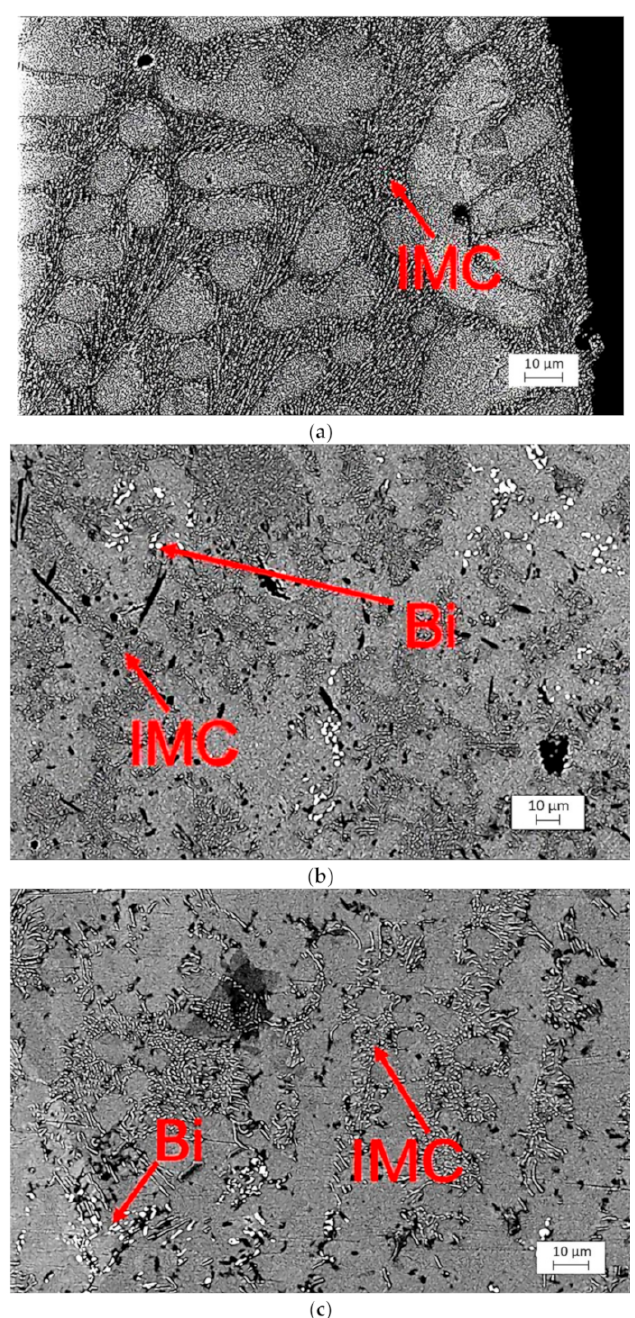
Figure 13. Microstructure comparison of several solder alloys. ( a ) SAC305; ( b ) SAC-Bi; ( c )